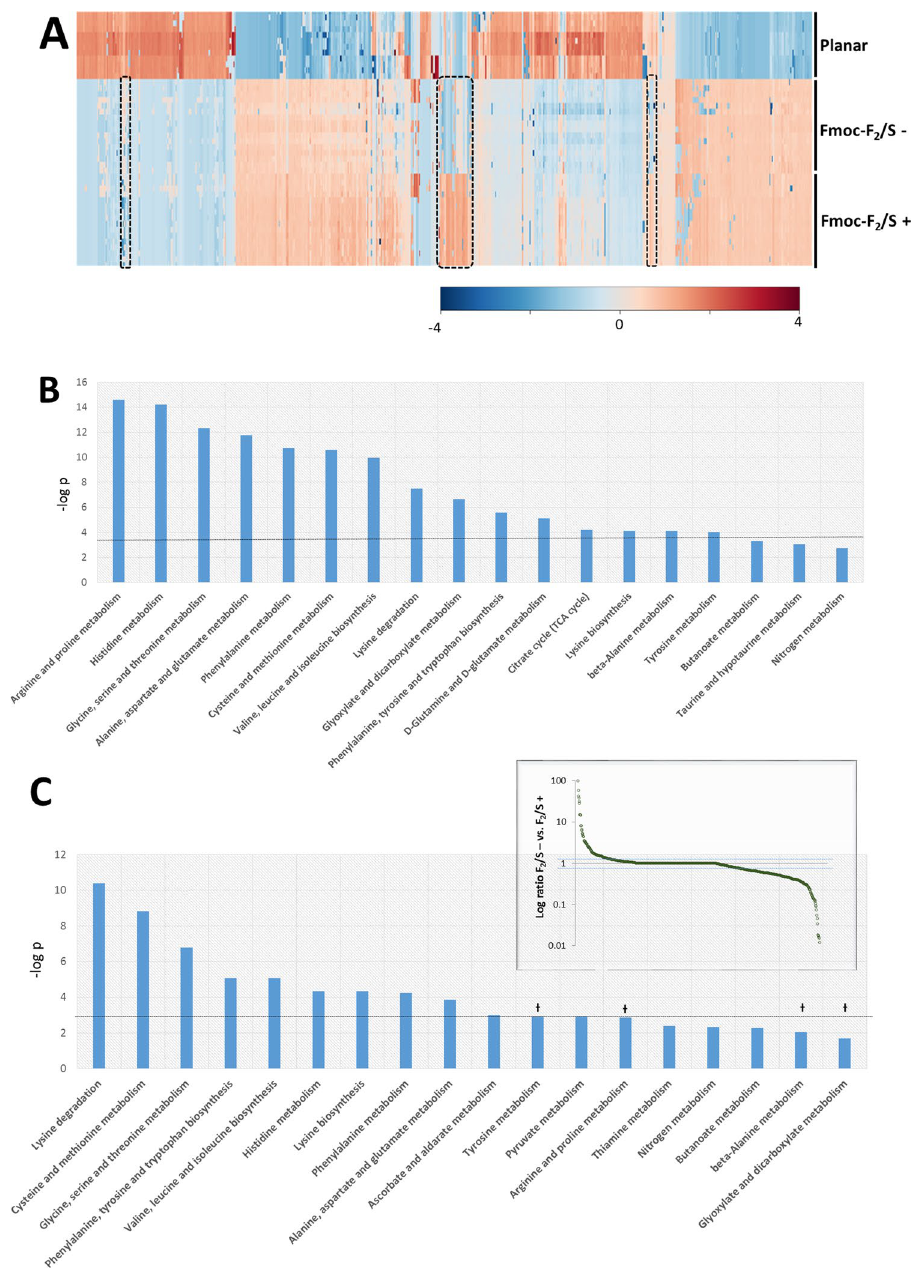
Figure 5. Analysis of metabolite masses detected from pericyte cell extracts undergoing chondrogenesis (n ≥ 12). ( A ) Hierarchical cluster analysis of metabolic MS masses detected using LC-MS for pericytes cultured on planar substrates (undifferentiated) and cultured in Fmoc-F 2 /S in the presence or absence of chondrogenic induction media 35 days. ( B ) Metabolites were mapped to metabolic pathways to ascertain which cell processes are significantly changed from the control. ( C ) Comparisons between Fmoc-F 2 /S − and Fmoc-F 2 /S + isolate metabolite masses that differ between the two by more than two fold (inset) giving insight into processes that lead to the altered chondrocyte phenotype between Fmoc-F 2 /S − and Fmoc-F 2 /S + Pathways marked with Ɨ were observed to be significantly different from undifferentiated cells but not between Fmoc-F 2 /S − and Fmoc-F 2 /S + suggesting influence during chondrogenesis but do not contribute to the observed differences in chondrocyte